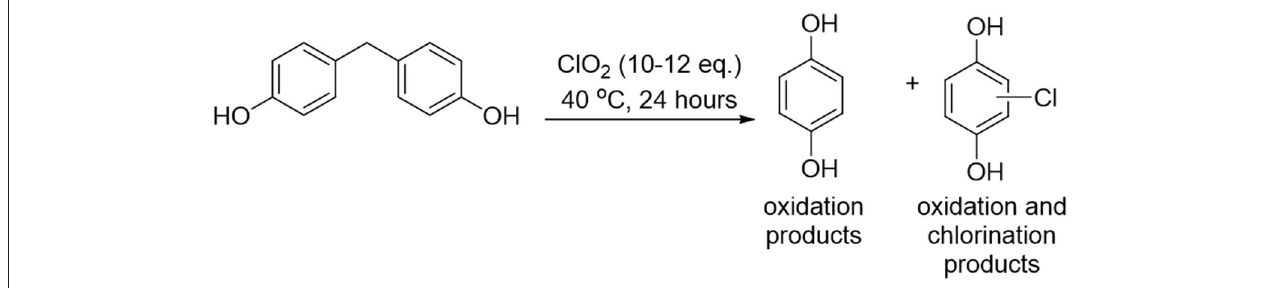
FIGURE 4 | Illustration of how the chlorine dioxide-mediated decomposition of bisphenol F leads to the formation of quinols and chloroquinols exclusively.